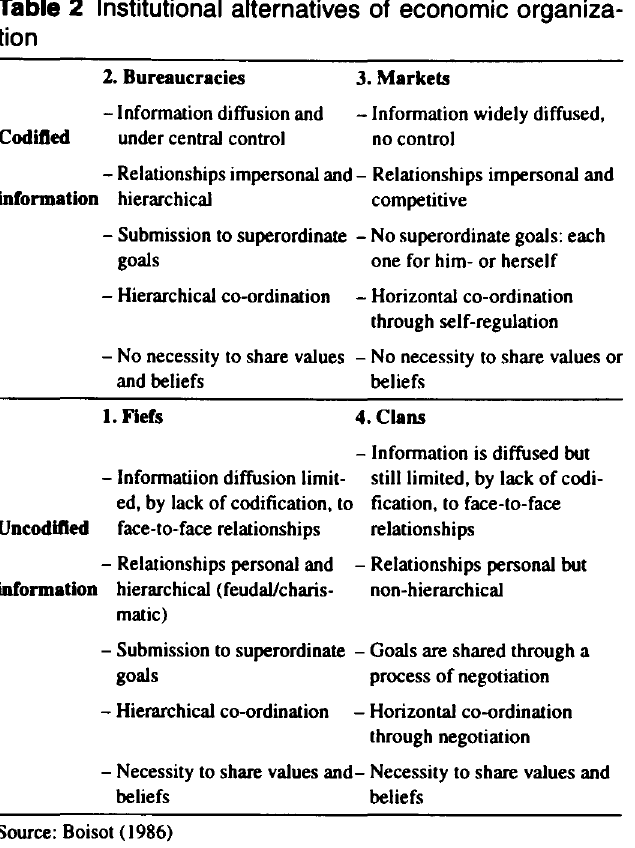
Table 2 Institutional alternatives of economic organiza